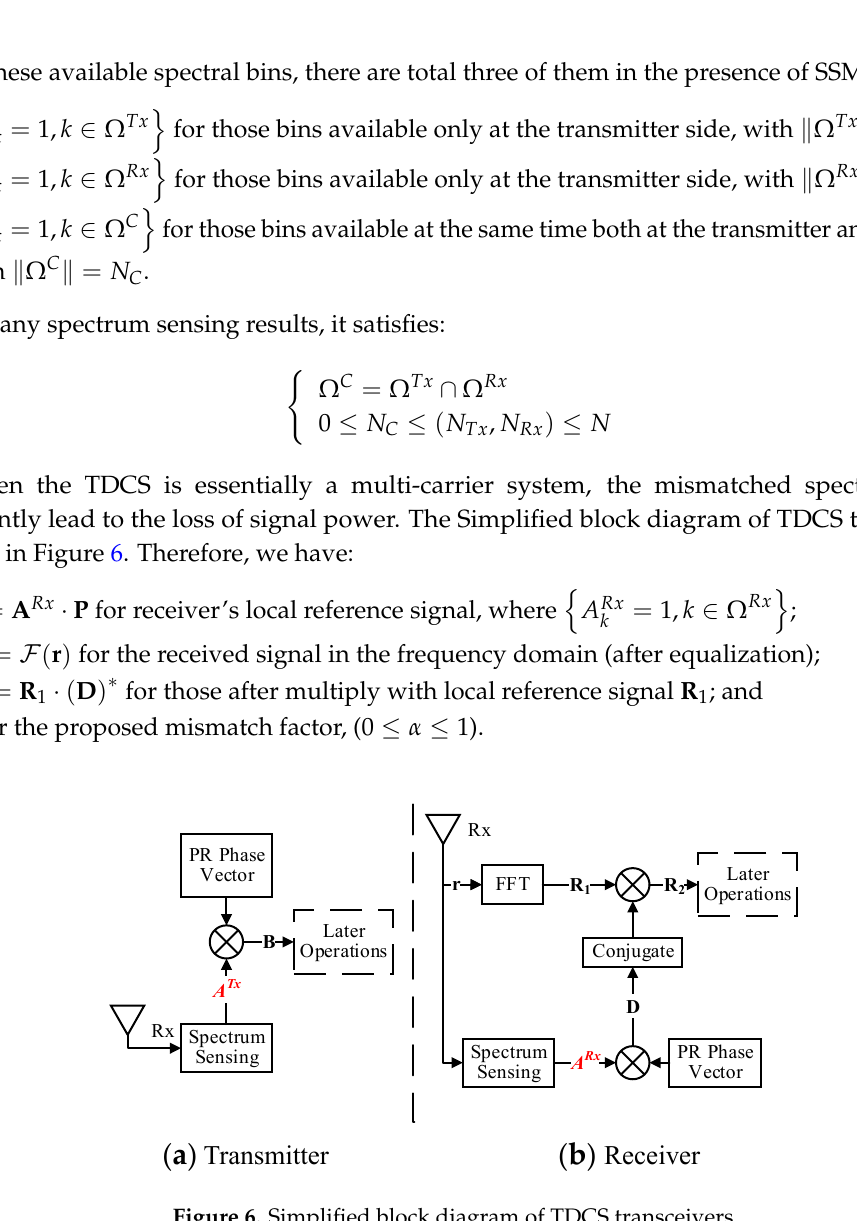
Figure 6. Simplified block diagram of TDCS transceivers.